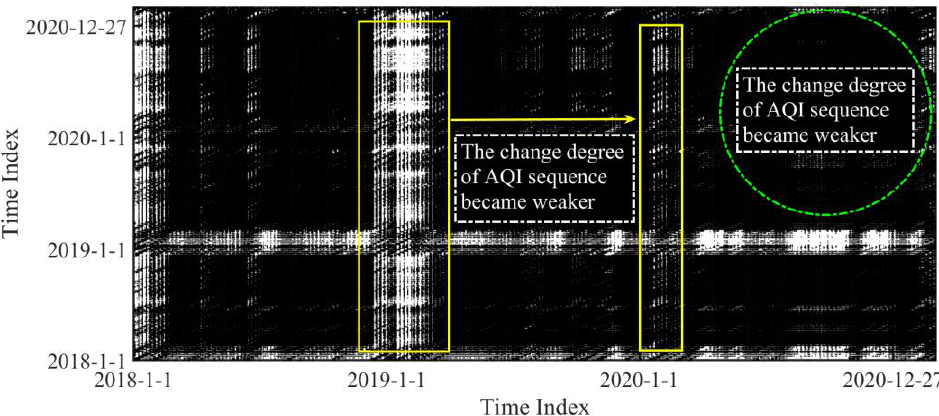
Figure 1. RQ plot for 12 cities that experienced severe epidemic conditions. (Note: black and white regions in the recursion graph represent the stability and instability of AQI sequence, respectively.)